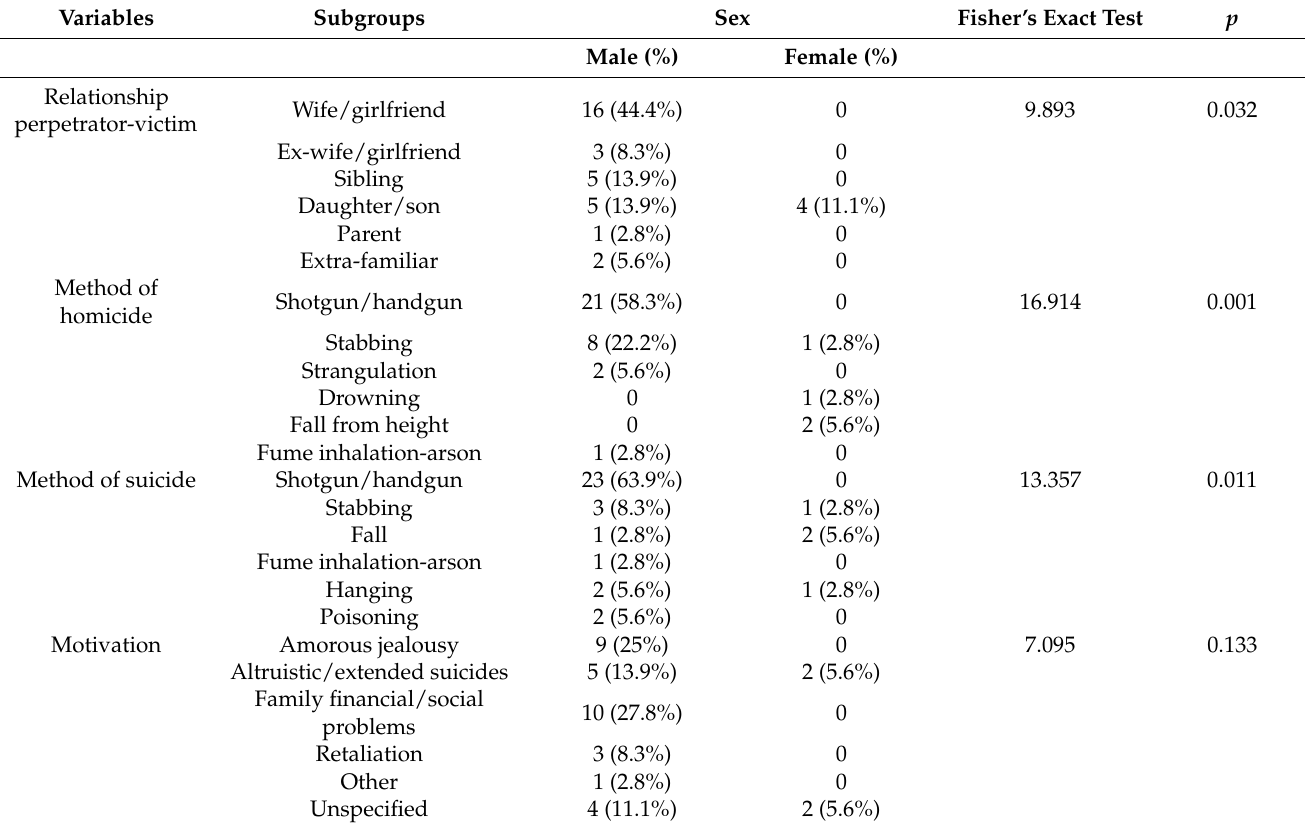
Table 2. Fisher’s exact test comparing relationships, method of homicide/suicide and motivation between male and female offenders ( n =